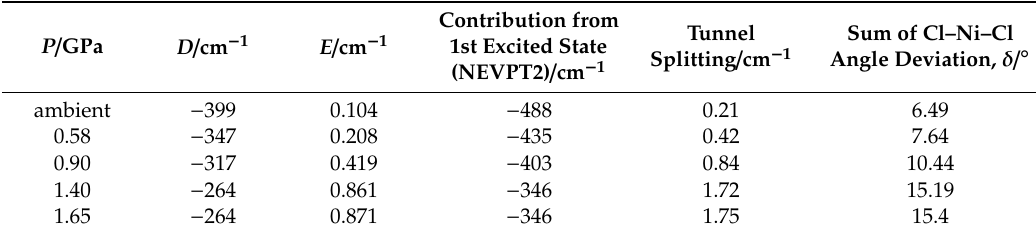
Table 9. NEVPT2 calculated D and E values computed from the high-pressure single-crystal X-ray data along with the most prominent contribution to D , the tunnel splitting of the M S = ± 1 levels, and the δ value computed for the structure.